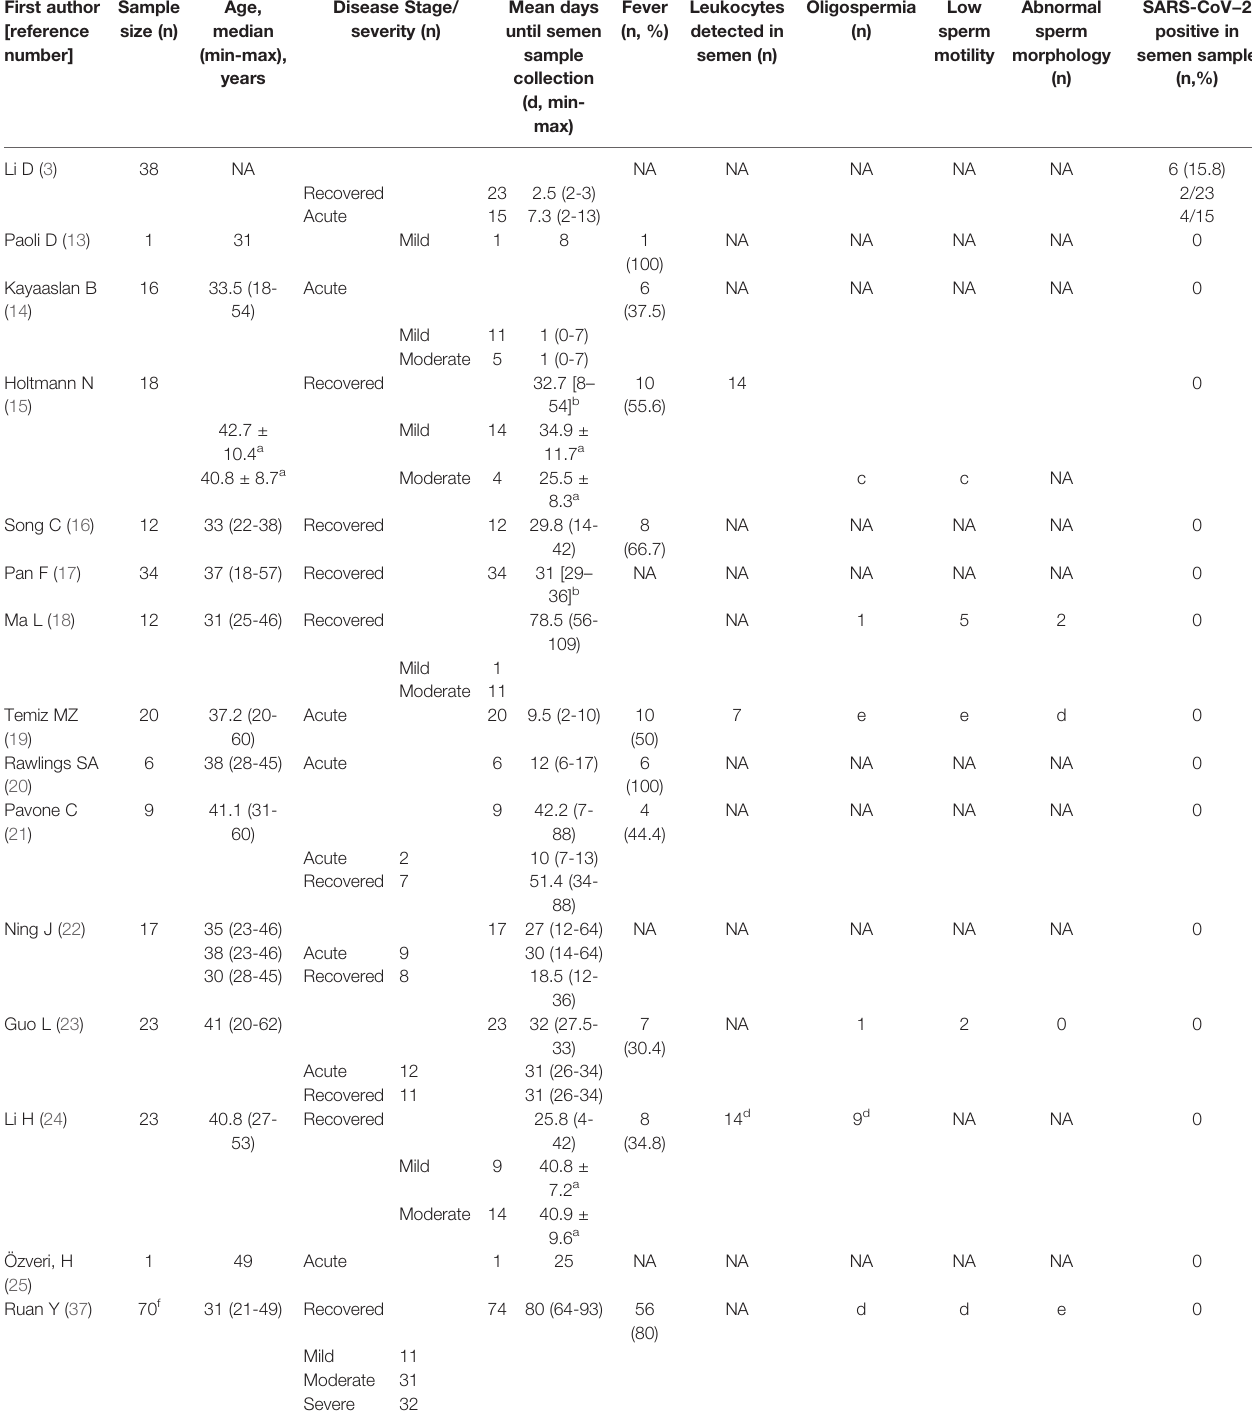
TABLE 2 | Semen Characteristics of Patients with